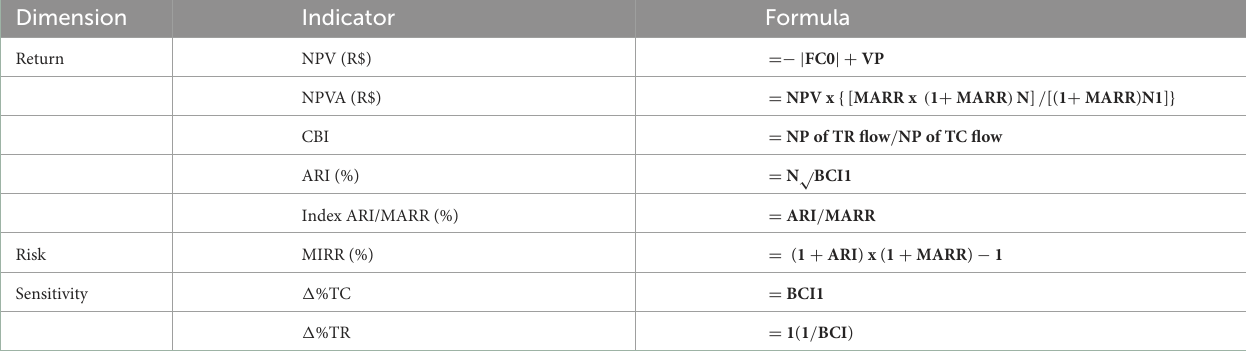
TABLE 2 Return, risk, and sensitivity indicators used at work. Dimension Indicator Formula